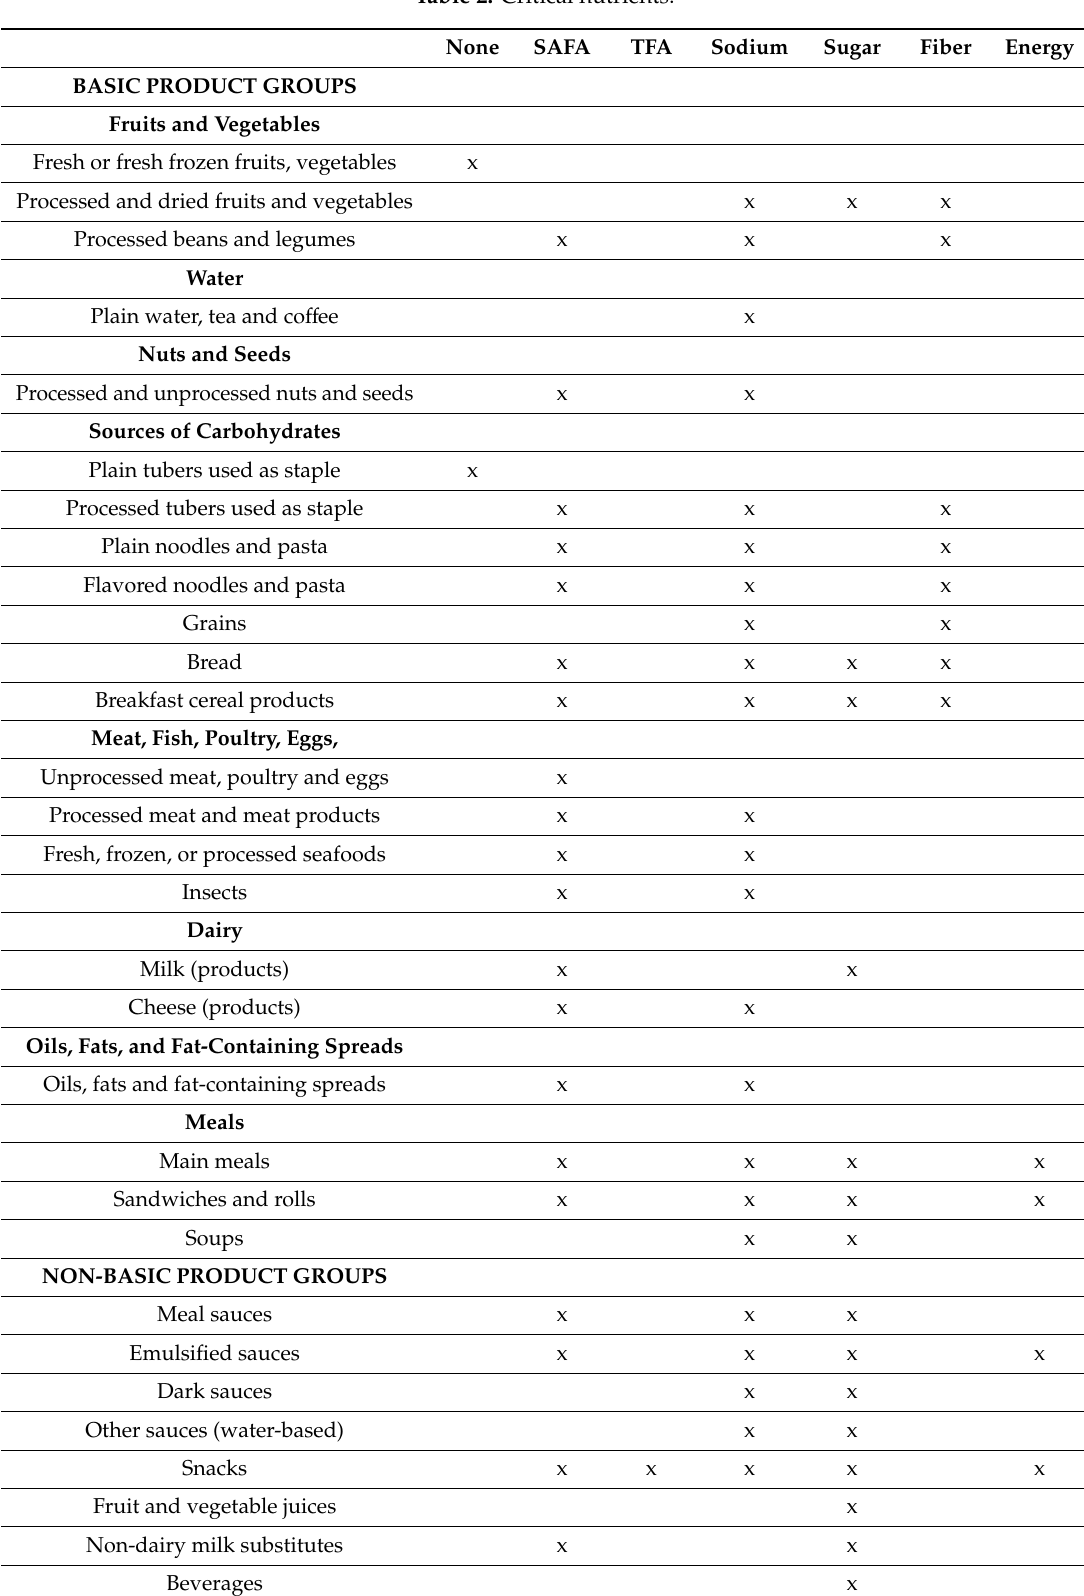
Table 2. Critical